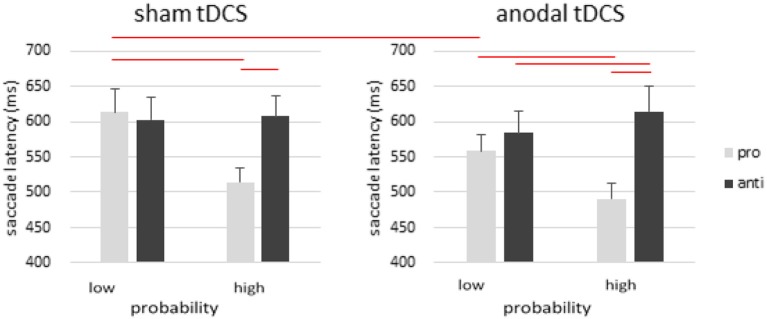
Effects of anodal tDCS on rFEF. There was a robust effect of location probability in prosaccades, as well as a pro- and anti-saccade tradeoff in the high probability condition such that antisaccades became slower even though probability information was only manipulated in prosaccades. Anodal tDCS over rFEF facilitated prosaccades toward the low-probability locations but not the high-probability location. Error bars represent standard error of the mean.